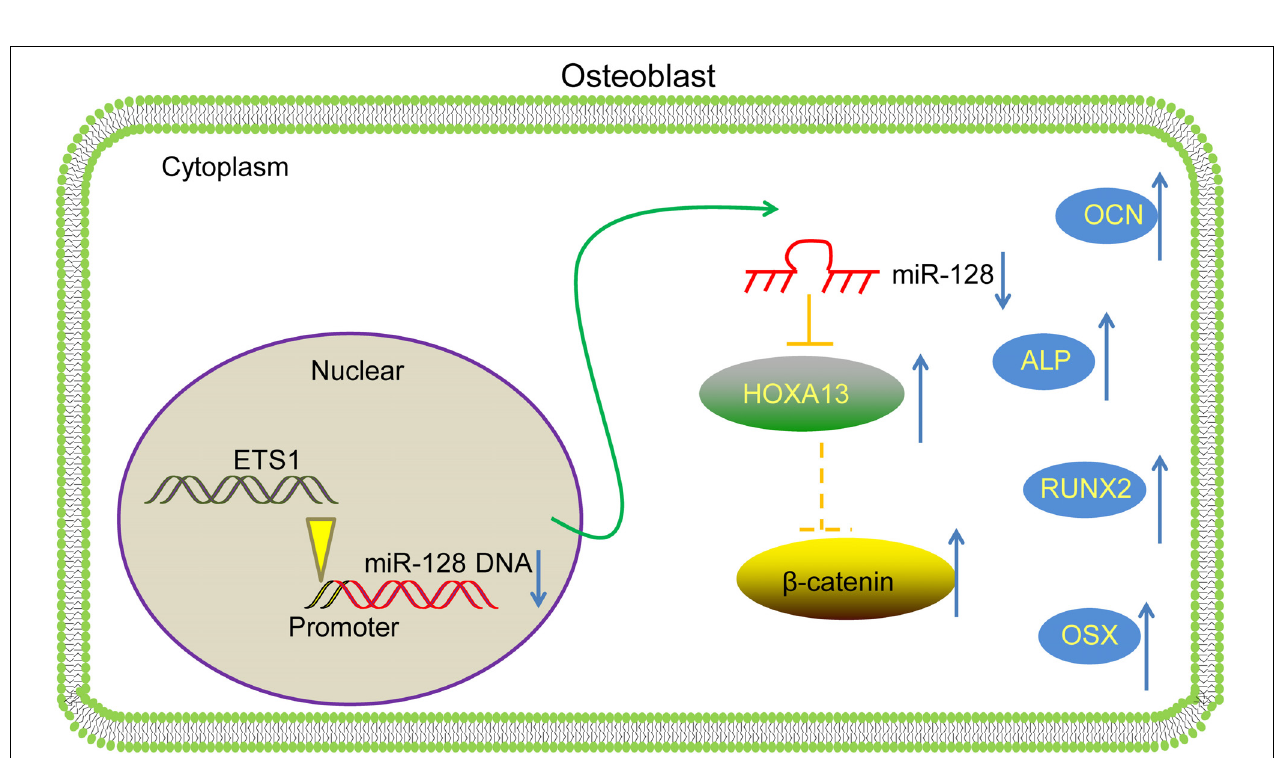
FIGURE 8 | A diagram for molecular mechanism. In MC3T3-E1 cells, ETS1 specifically binds to the promoter region of miR-128 to suppress its transcription, leading to further activation of the HOXA13/ β -catenin axis, therefore promoting the osteogenic differentiation of cells.